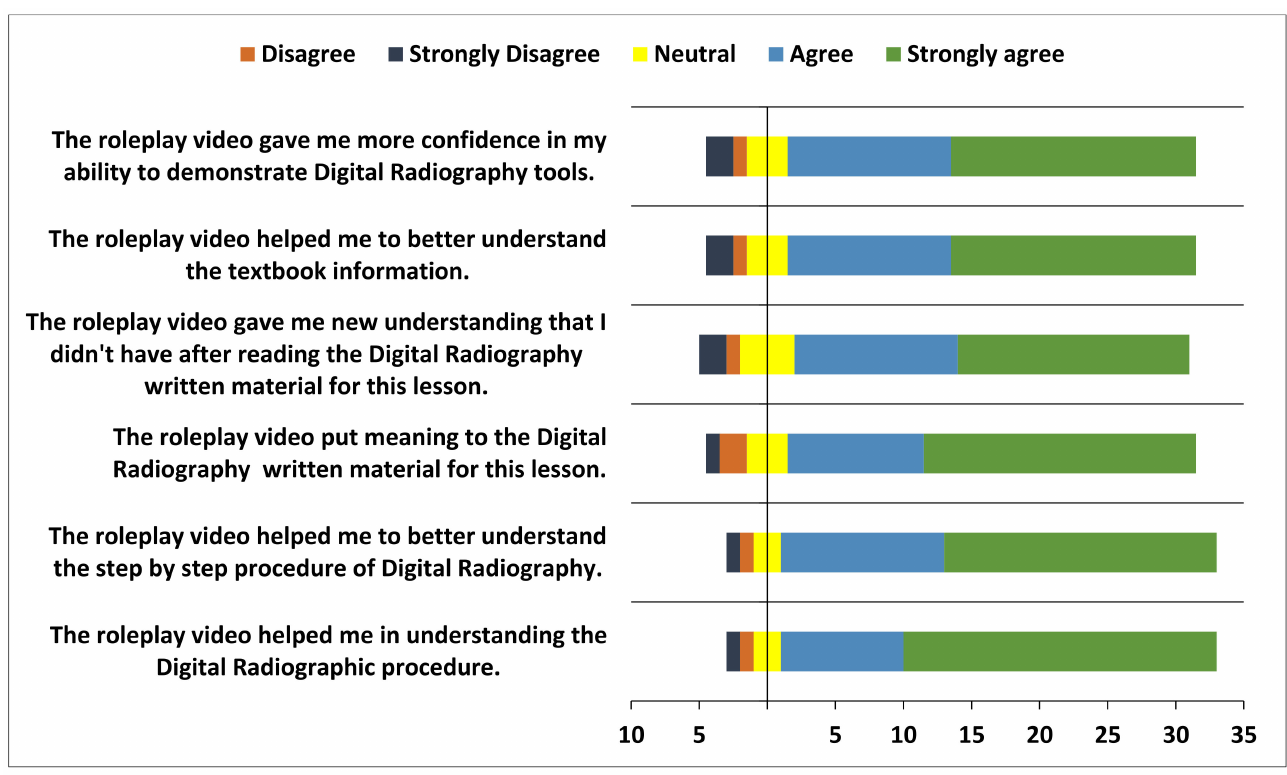
Figure 2. Responses of the participants towards roleplay soft skills in Periodontics discipline.